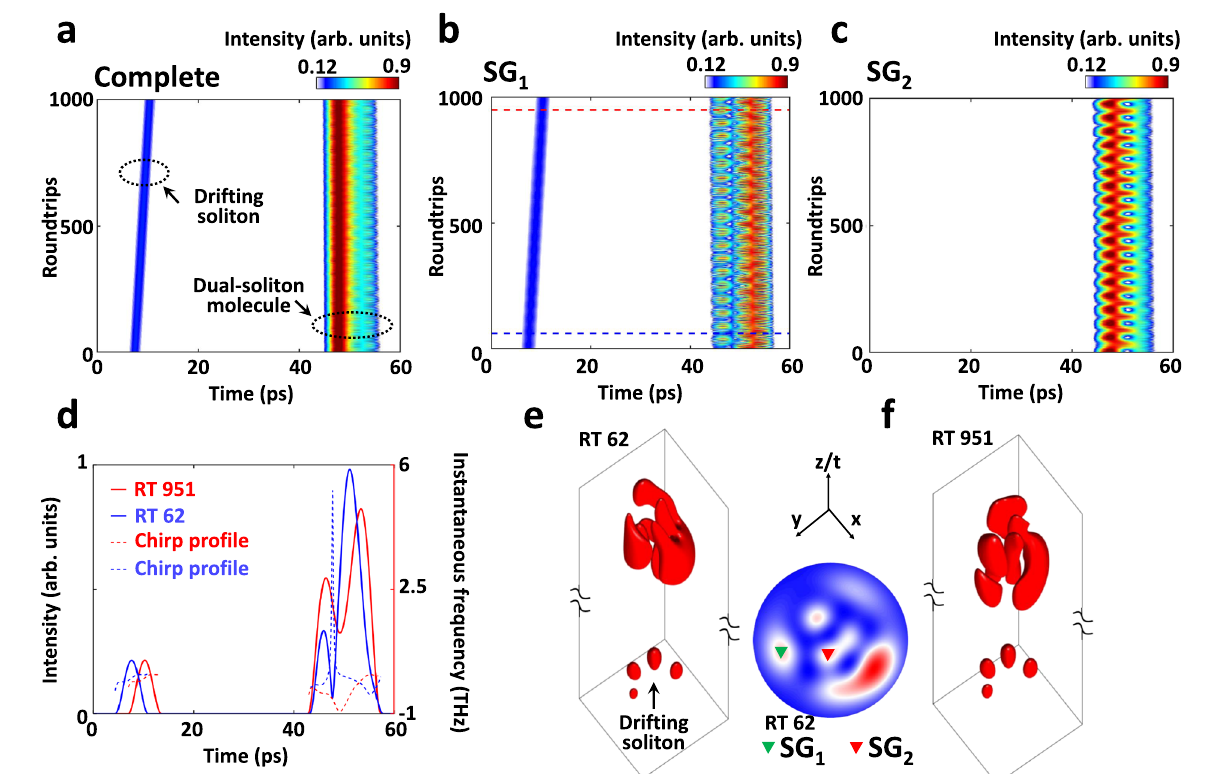
dotted squares in ( a ) and ( b ). Here, 3D plots are used for better visualization. e , f Corresponding fi eld autocorrelation (FAC) evolutions of ( a ) and ( b ), respectively.